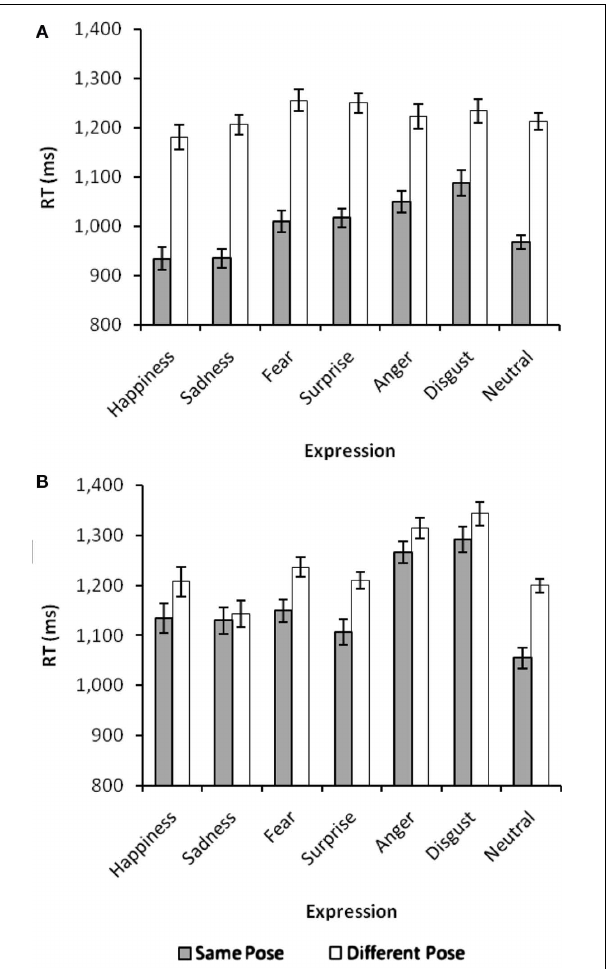
FIGURE 2 | (A) Matching accuracy in Experiment 1. (B) Matching accuracy in Experiment 2. p < 0.01, partial η 2 = 0.07. Simple main effect analysis suggested